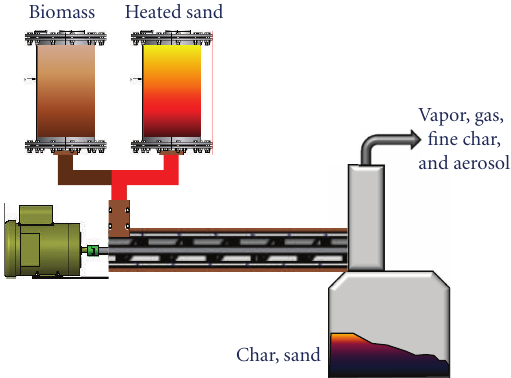
Figure 8: Auger/screw pyrolysis reactor concept using heat carrier.